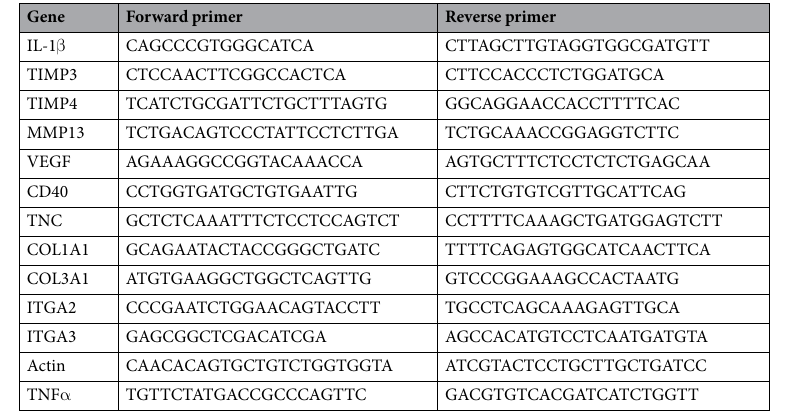
Table 2. List of primers used for